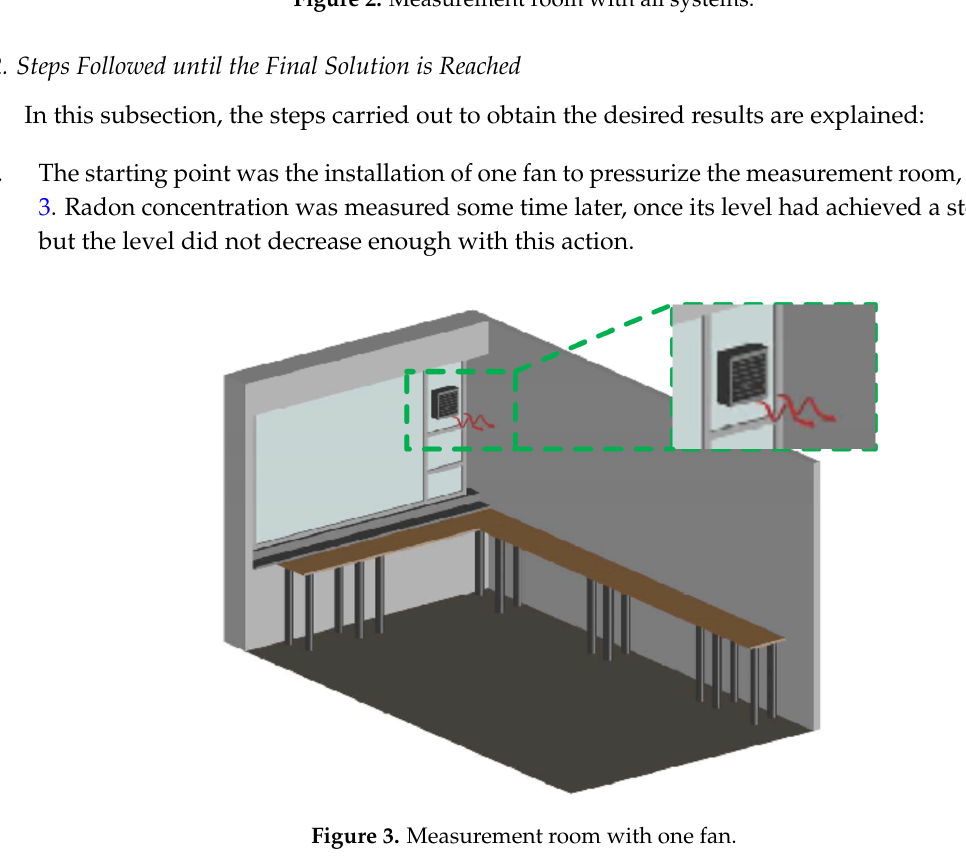
Figure 2. Measurement room with all systems.